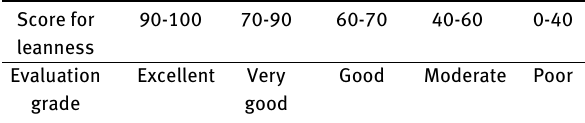
Table 7: Classification of sustainable competitive advantage Score